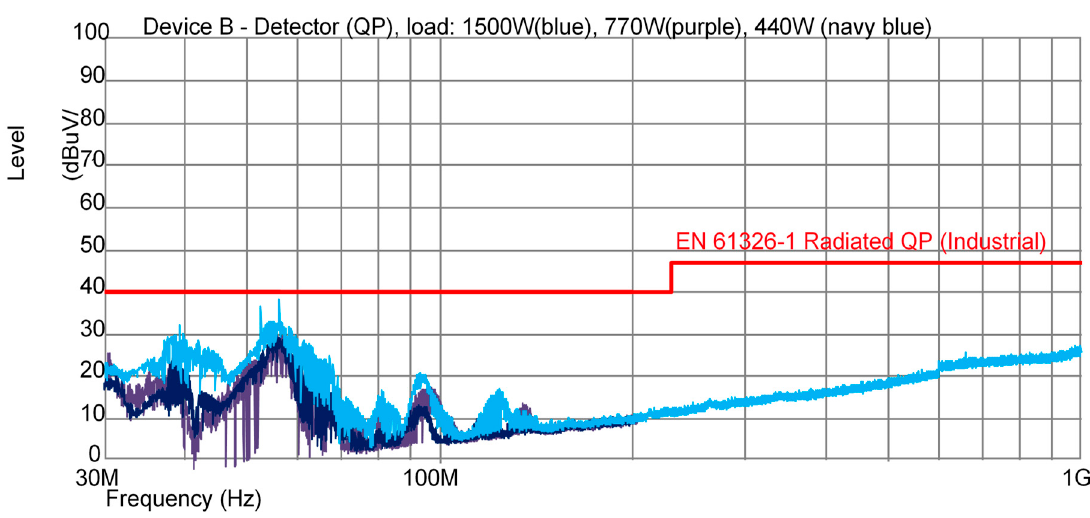
Figure 9. Frequency spectrum of radiated emission of audio power amplifier (device B) for frequency of generated voltage equal to 50 Hz and the values of the active load power equal to 1500, 770, and 440 W.